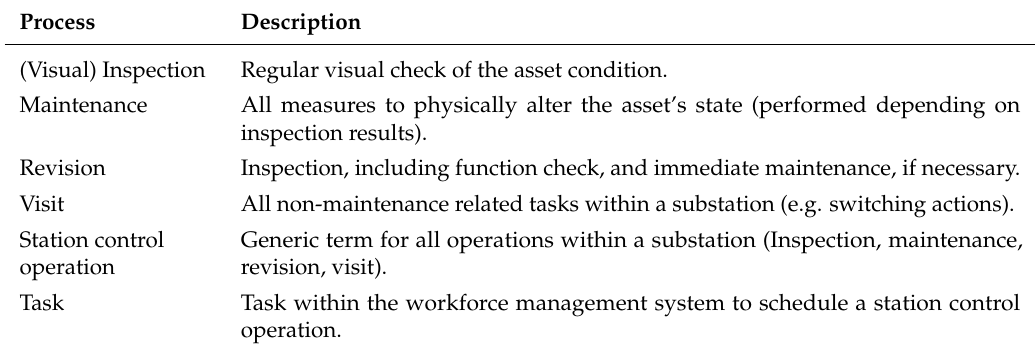
Table 1. Overview of substation asset management nomenclature (For definitions refer to norm